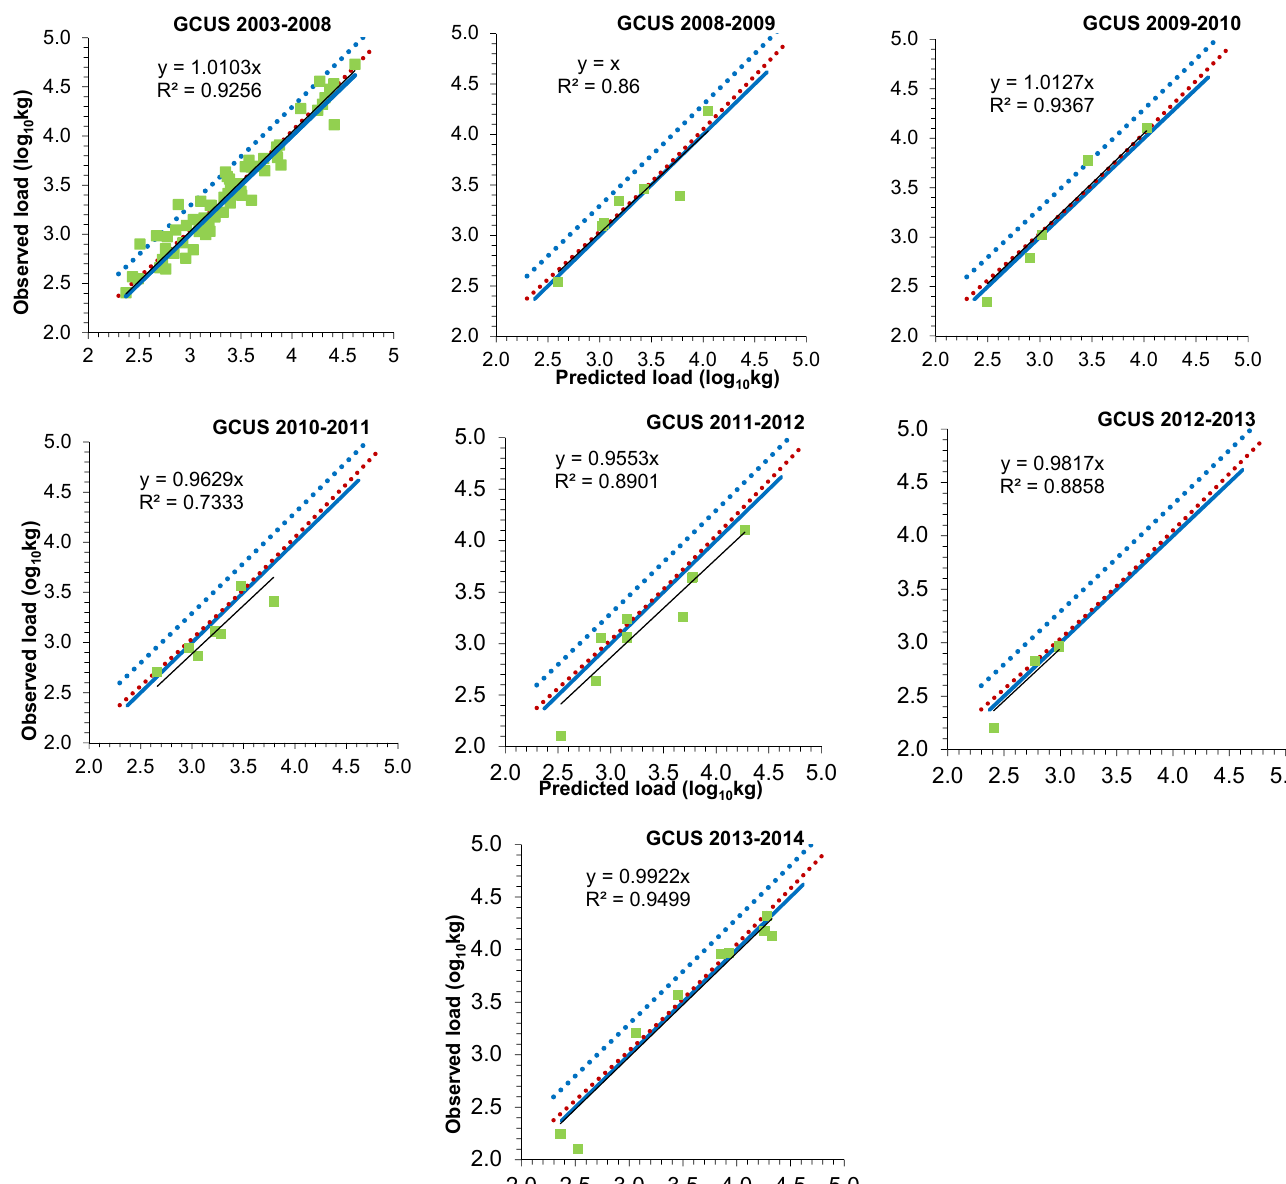
Figure A1. Relationship between OTL and PTL at GCUS (2003–2014).